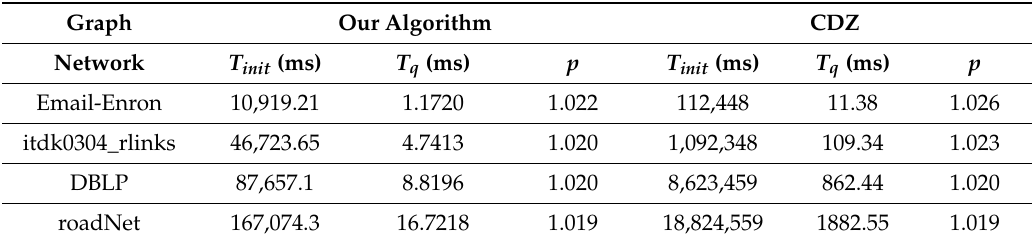
Table 2. Runtime and accuracy of CDZ and our algorithm on four networks.